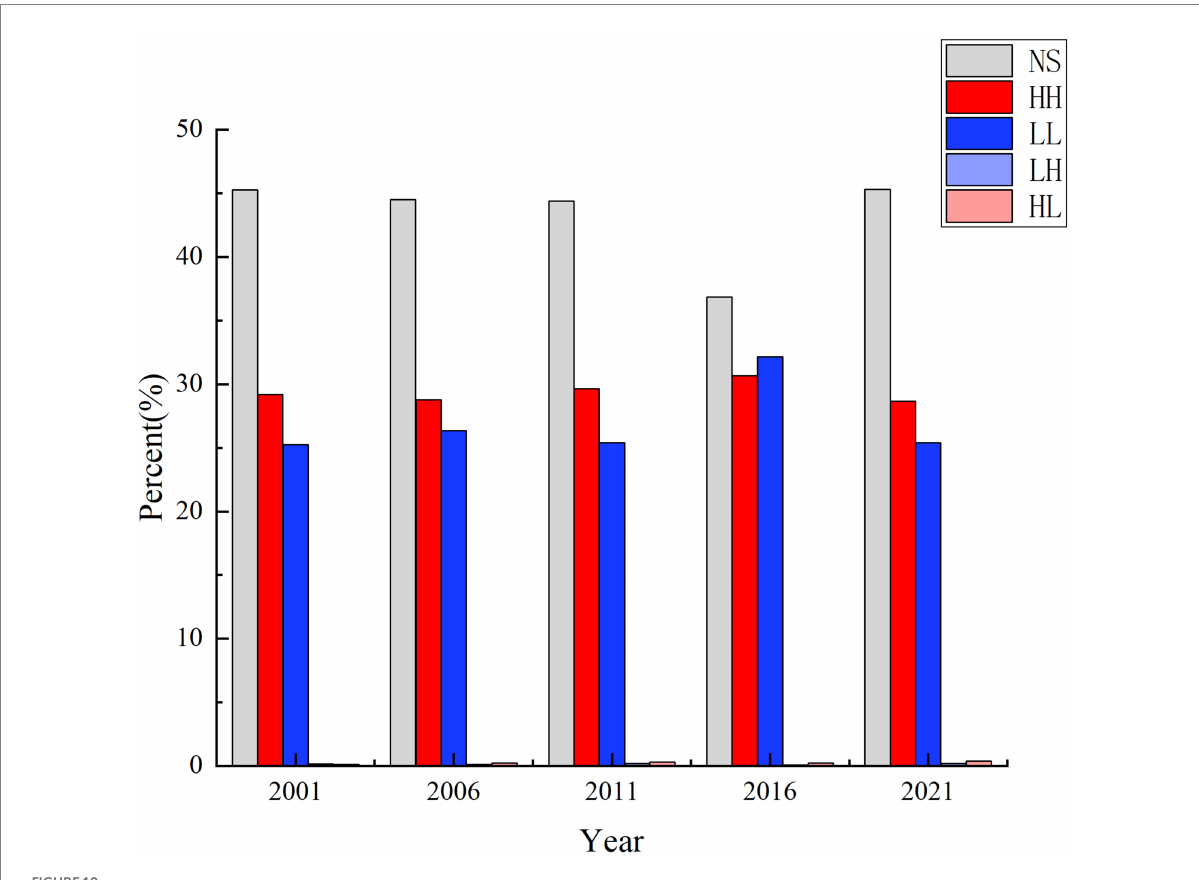
FIGURE 10 Area proportion of each clustering